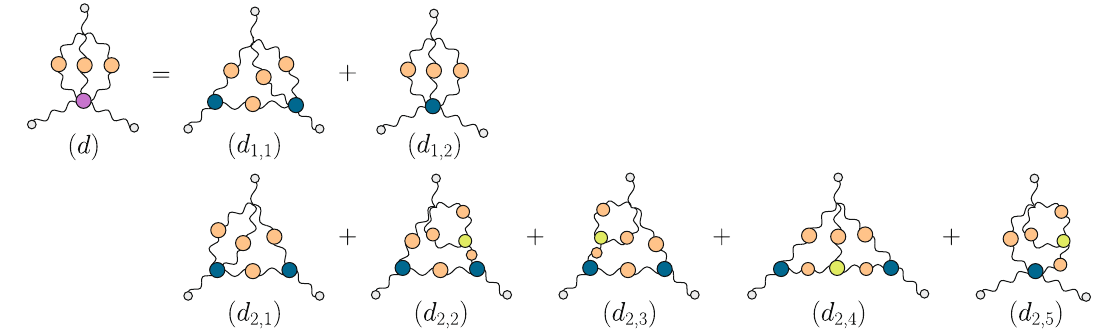
Fig. 5 The seven contributions originating from diagram ( d ) of the Fig. 2. This group splits into two subsets: the first composed by the diagrams { ( d ),( d ) } and the second by { ( d 1 , 1 1 , 2 × (cid:3) R ητ ( l + p , q − l ) (cid:3) (cid:6) νλη ( p , l , − l − p μ